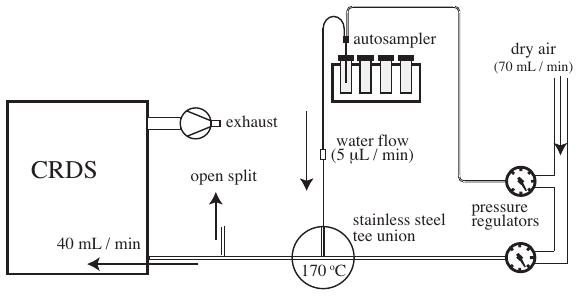
Figure 2. Schematic of custom vaporizer design used for isotope ratio measurements over long integration times. Double lines denote 1/16 inch and 1/32 inch stainless steel tubing (outside diameter). Single lines denote fused-silica capillary (0.3mm inside diameter exiting the vials, reduced to 0.1mm where the capillary enters the